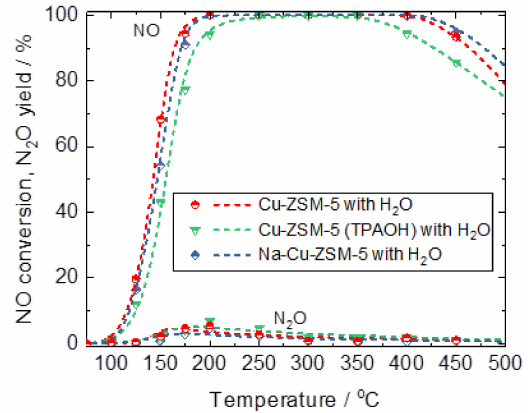
Figure 12. Results of catalytic studies: NO conversion and N 2 O yield (reaction conditions: 0.2 g of catalyst, 120 mL min − 1 , 500 ppm NO, 575 ppm NH 3 , 4 vol.% O 2 , 5 vol.% H 2 O and He balance, GHSV = 30,000 h − 1 ).